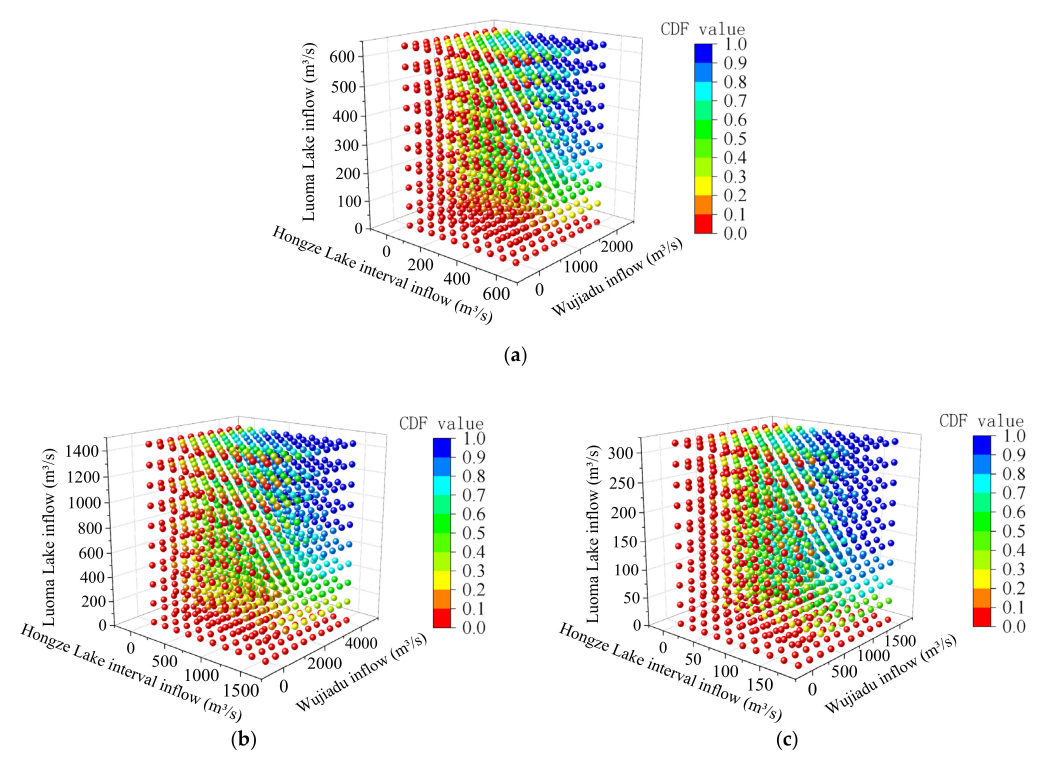
Figure 7. The function images of the joint distributions at three scales: ( a ) is under the annual scale; ( b ) is in flood season; and ( c ) is in non-flood